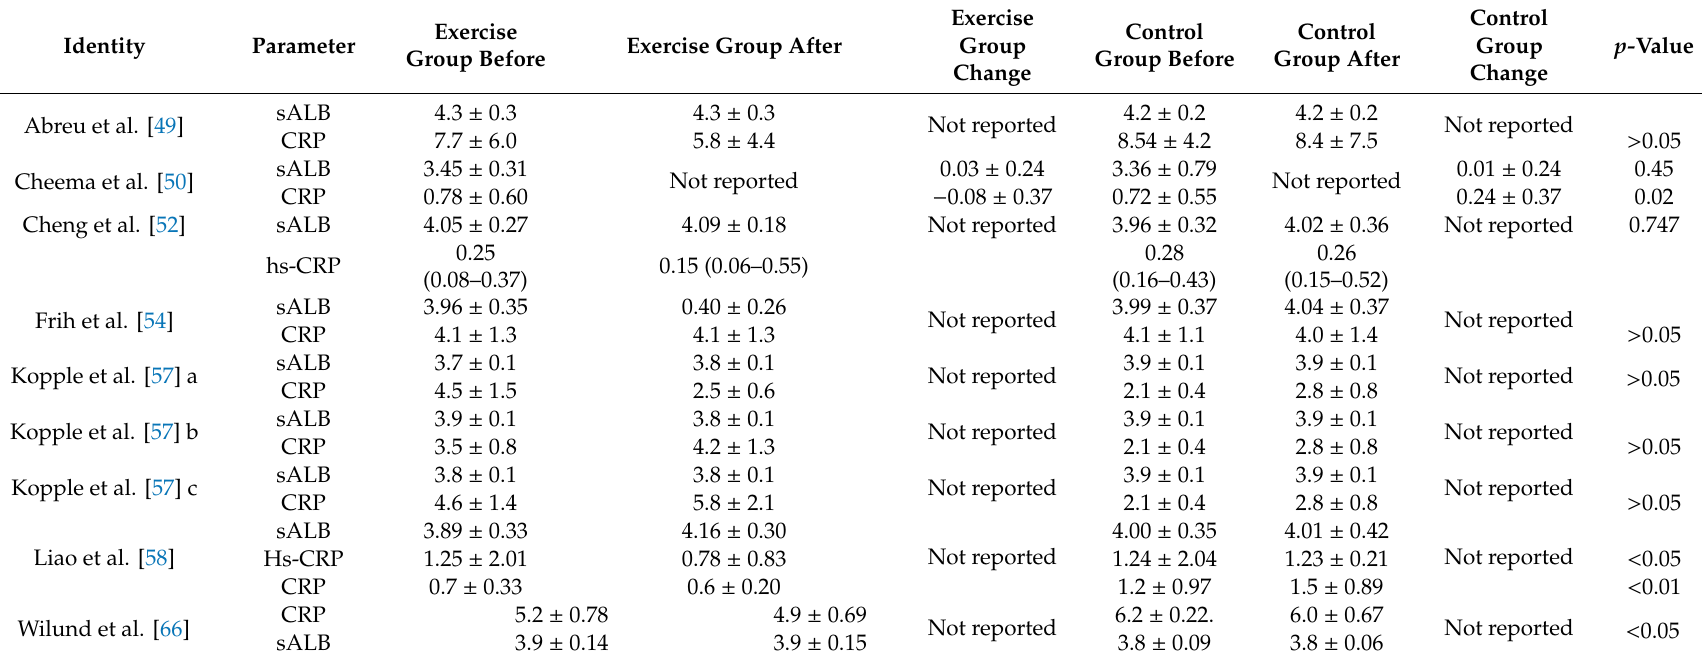
Table 7. Changes in sALB (g / dl) and CRP (mg /